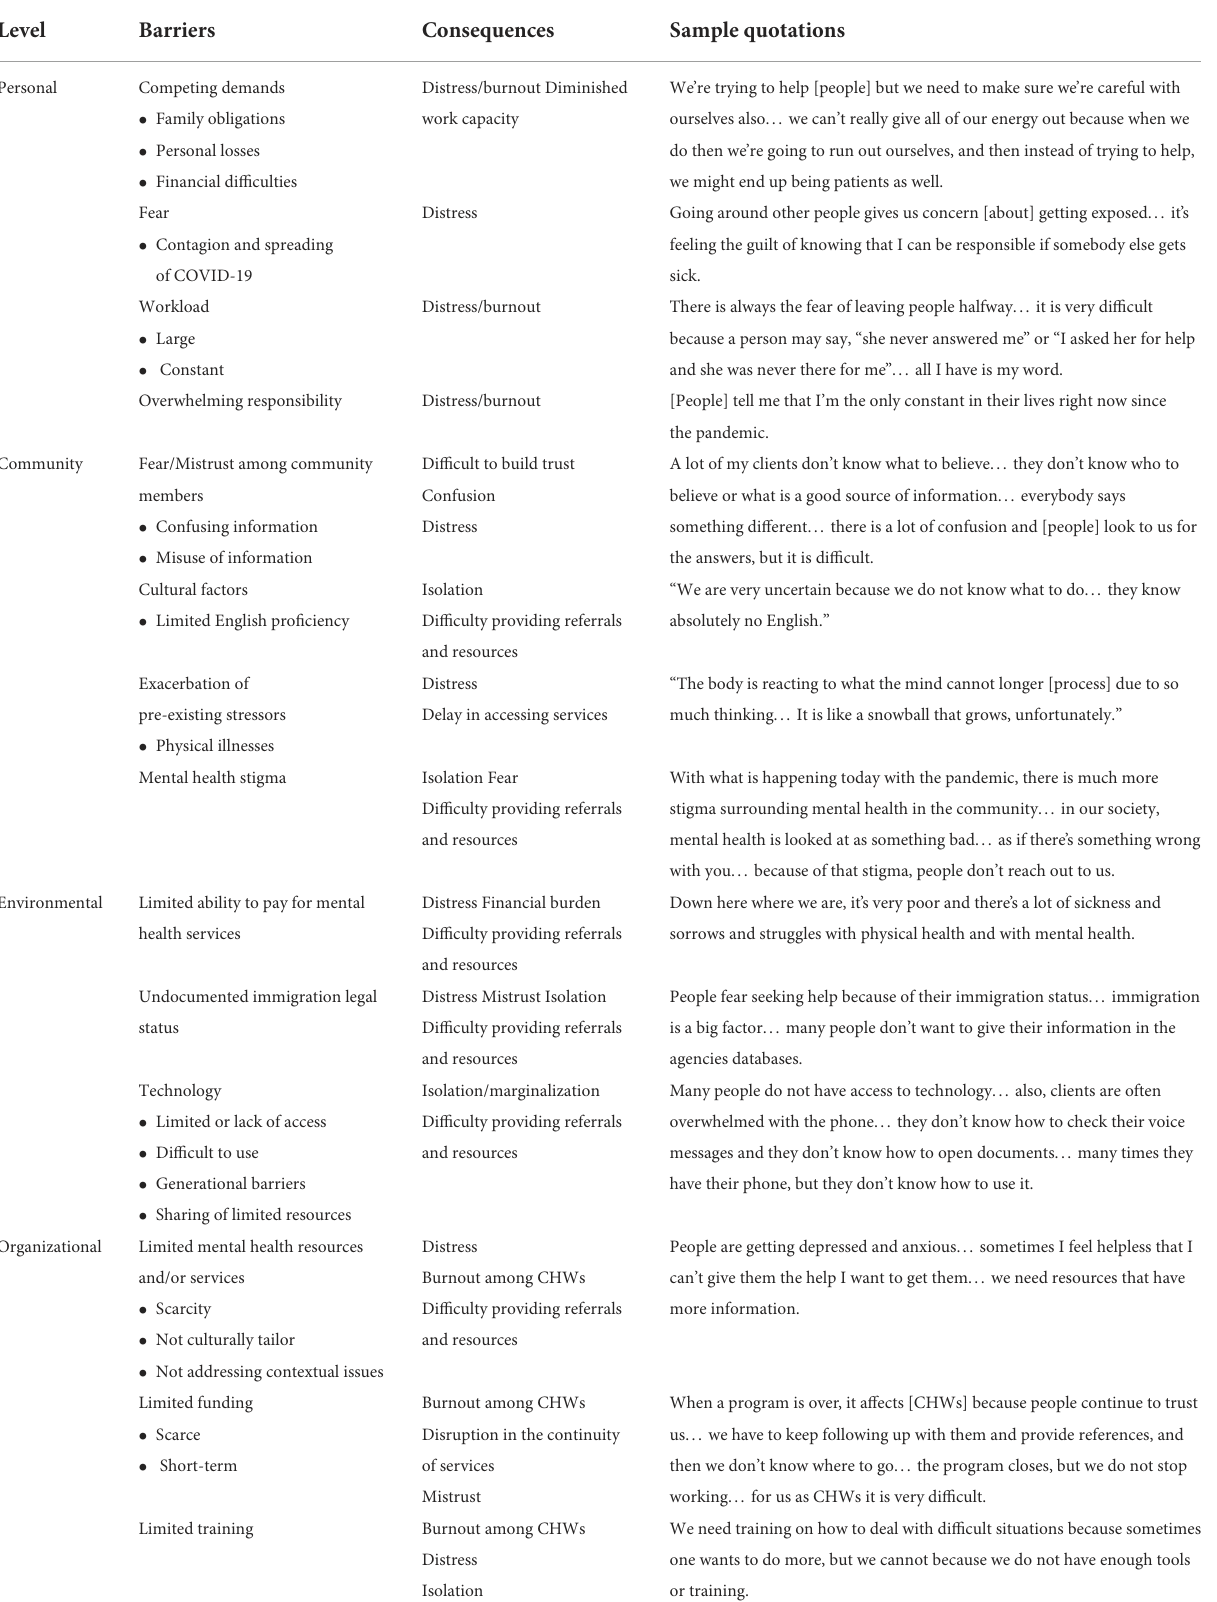
TABLE 2 Barriers to the work of CHWs, their consequences, and sample quotations.